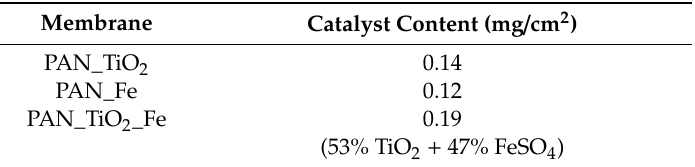
Table 2. Catalyst content of the membranes.